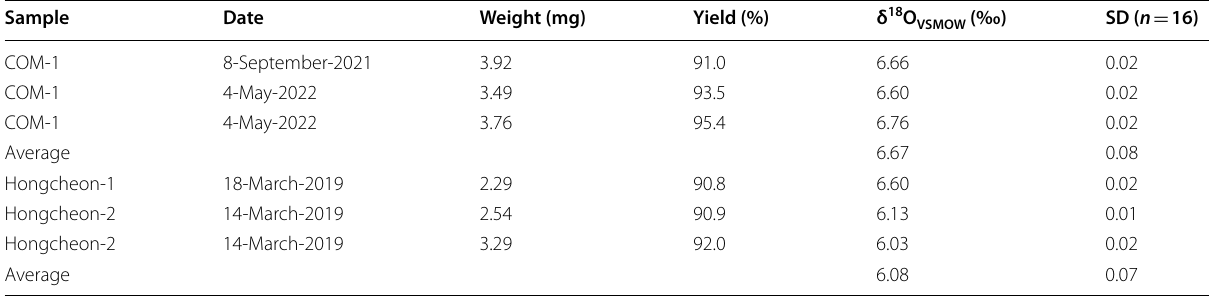
Table 2 Oxygen isotopic compositions of the COM‑1 and Hongcheon monazites, measured by gas‑source mass spectrometry